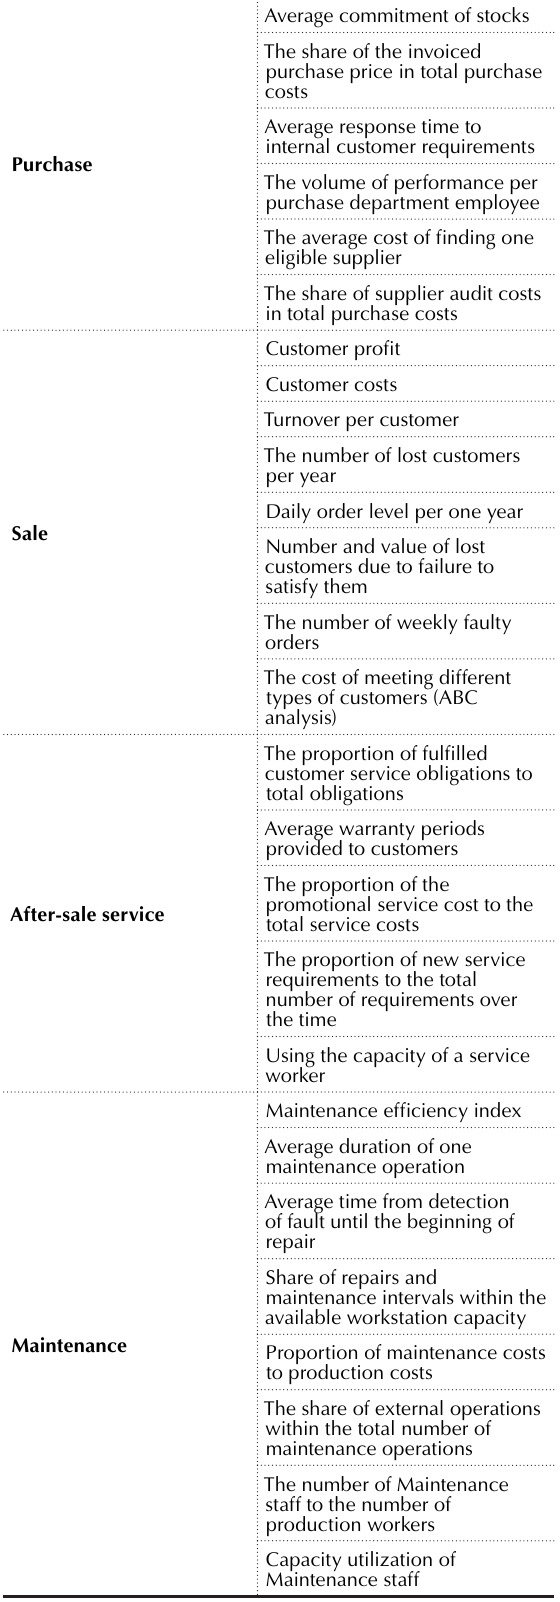
Table 4 (cont). Indicators of measuring performance of non-production